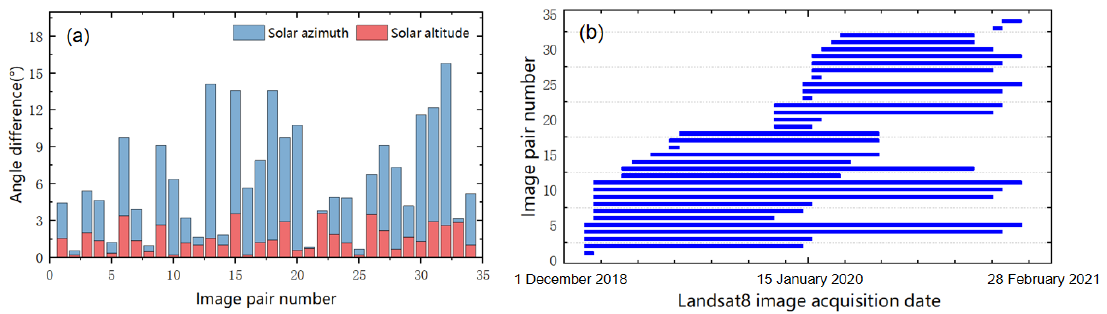
Figure 4. Landsat 8 image pairs and their angle difference. ( a ) Difference between the solar altitude angle and solar azimuth angle for each image pair. ( b ) Time baseline for each image pair.